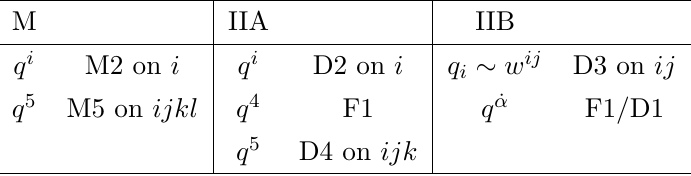
Table 3 . Partially wrapped branes (strings): q a